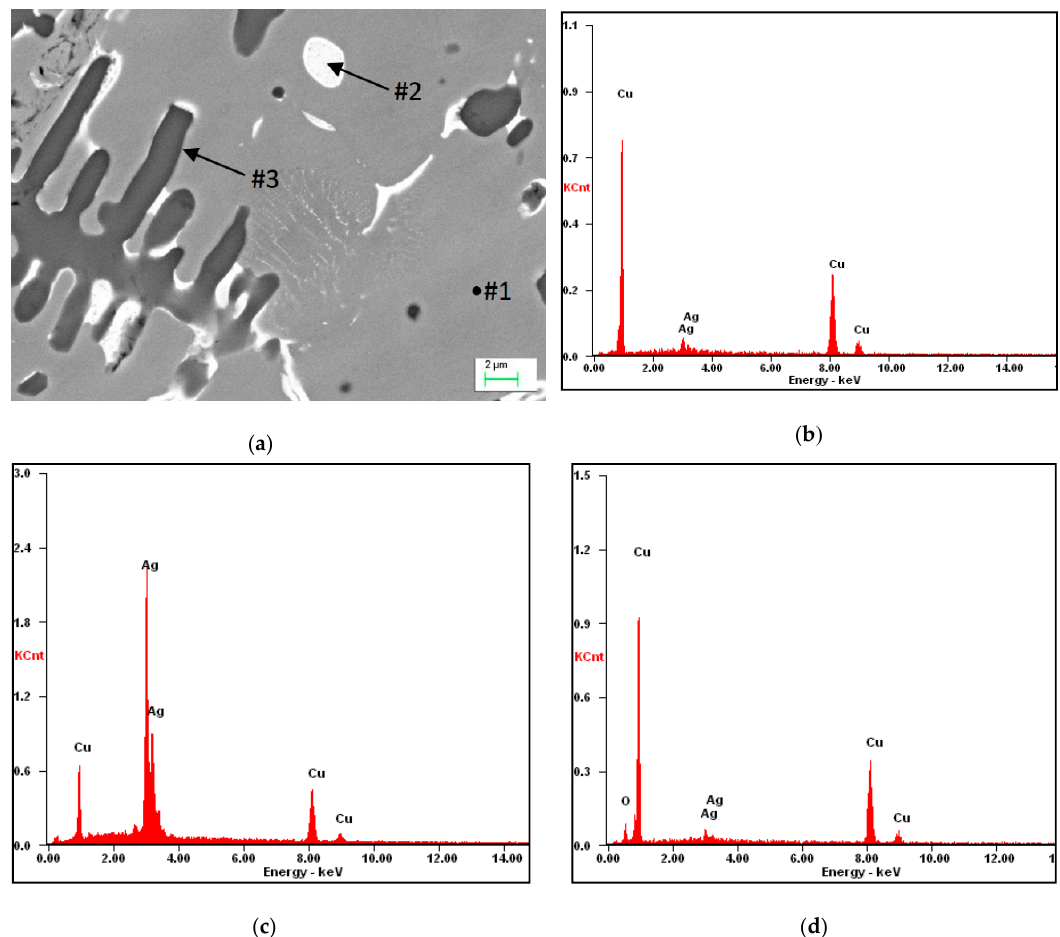
Figure 6. ( a ) Microstructure of Cu after alloying by Ag: #2 Cu + Ag eutectic; ( b ) analysis of energy dispersive x-ray spectroscopy (EDS) from the micro-area #1; ( c ) analysis of EDS from the micro-area #2; and ( d ) analysis of EDS from the micro-area #3. Table 2. Results of the EDS spectrum analysis for the areas from Figure 6 (wt.%).